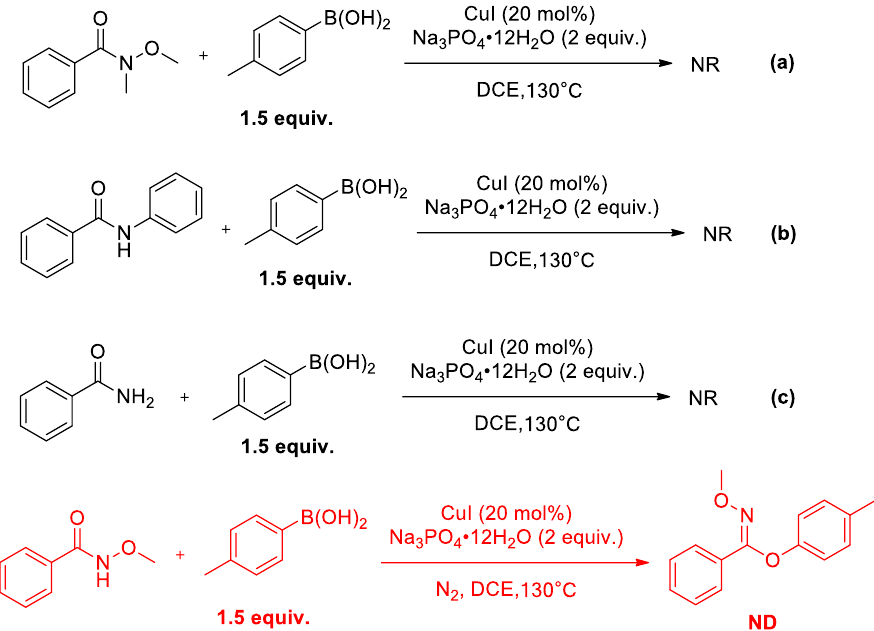
Scheme 4. Control experiments of the copper-catalyzed C-O coupling reaction.